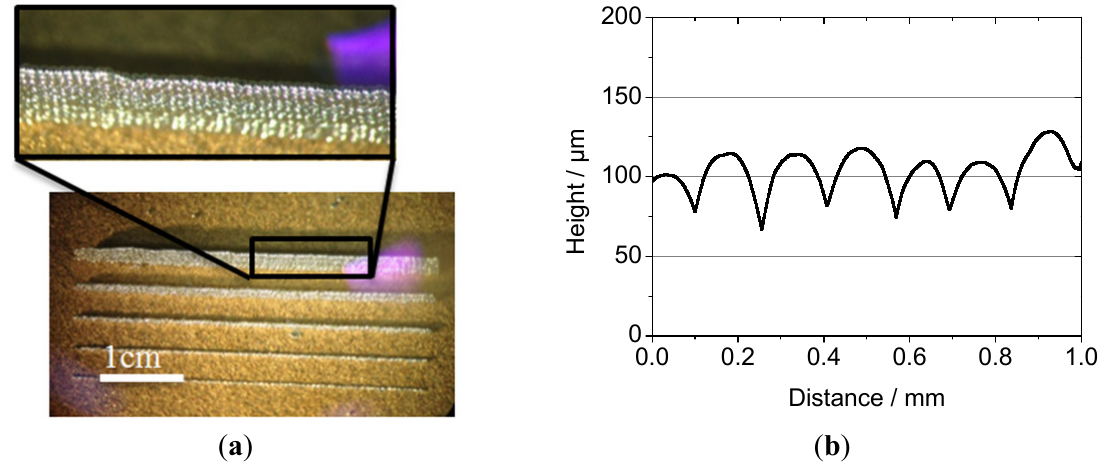
Figure 15. ( a ) Picture of in DoD-mode printed IMTEK logo, droplet diameter approximately 144 μ m. ( b ) Surface measurement of the printed